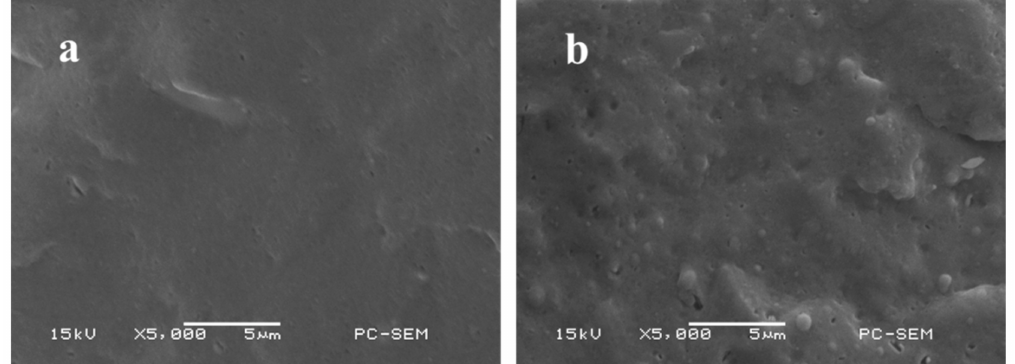
Figure 2. SEM micrographs of PPC and PPC/TPU blends. ( a ) Neat PPC, ( b ) PPC/10%